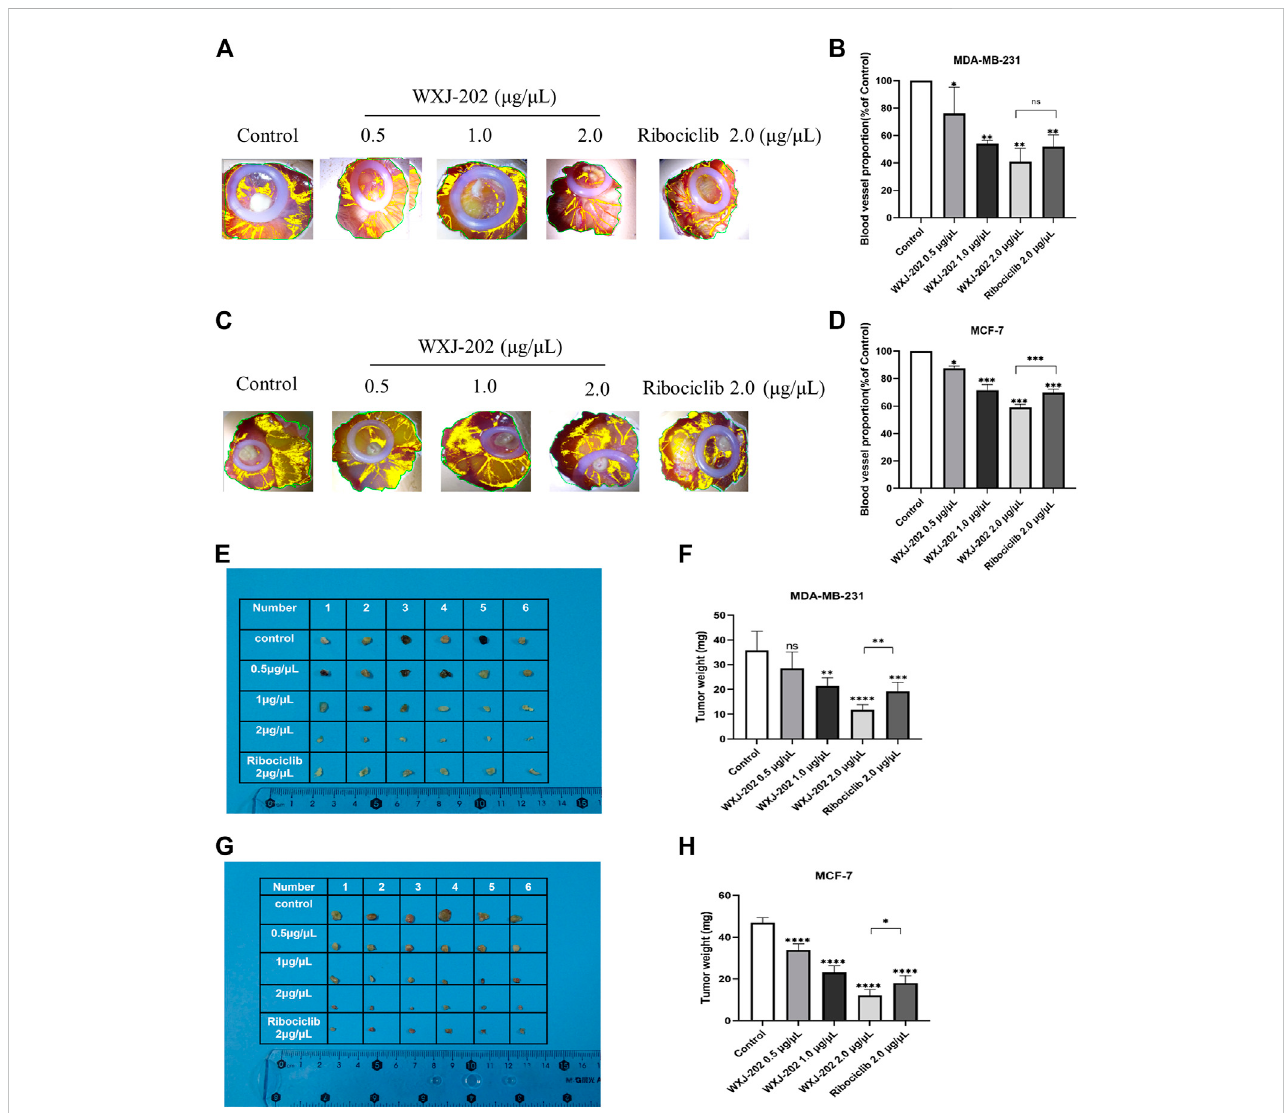
FIGURE 9 Effects of compound WXJ-202 and Ribociclib on the chicken embryo chorioallantoic membrane model. (A – D) Statistical graphs of the neo-vascular situation and the number of vessels ( n = 3). (E – H) Statistical diagram of the growth of resected tumors and the weight of tumors in each group ( n = 6). * p < 0.05 vs control, ** p < 0.01 vs. control, *** p < 0.001 vs. control, **** p < 0.0001 vs.